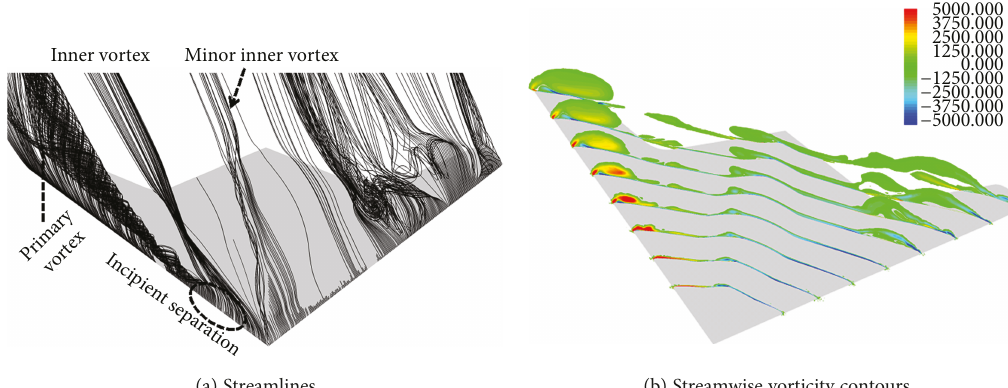
Figure 15: Streamlines and streamwise vorticity contours at α = 16 ° and β = 20 °